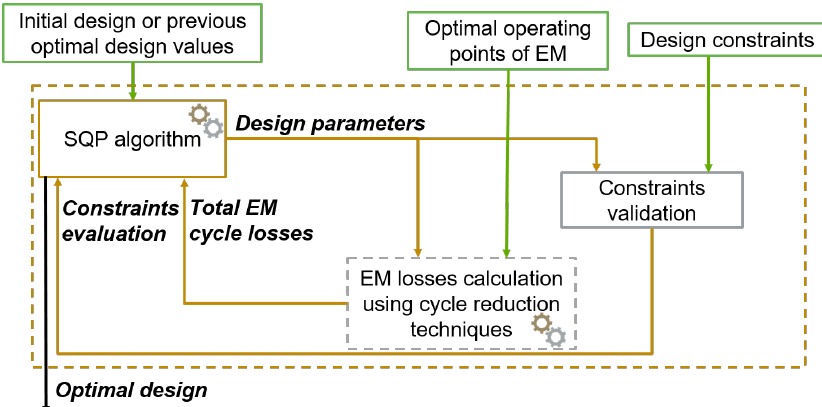
Figure 10. Design optimization block of IT + CR